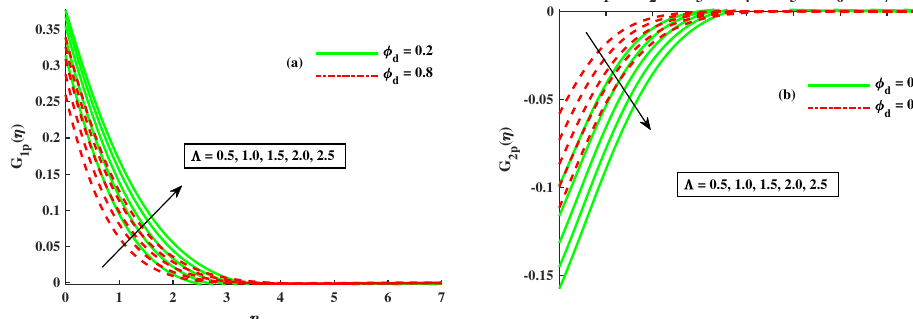
Figure 6. Fluctuation of Λ and φ d on G 1 p and G 2 p .